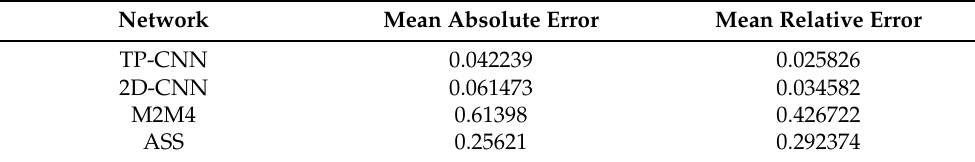
Table 3. Performance metrics of the four algorithms for SNR evaluation after dataset update.